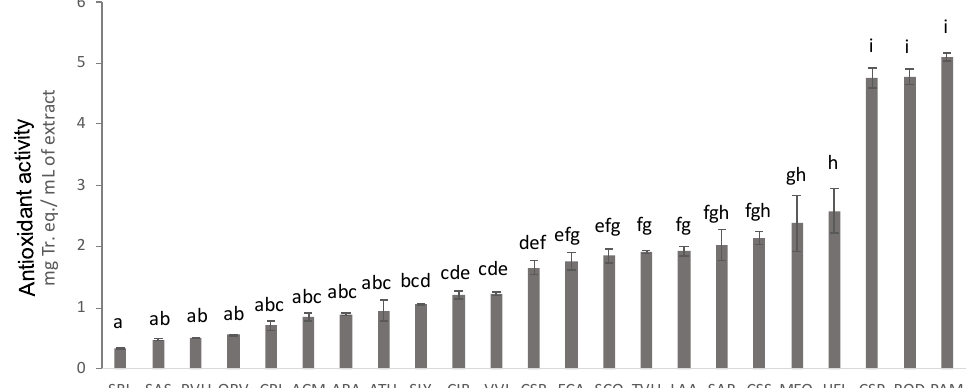
Figure 1. Antioxidant activity expressed in mg of Trolox equivalent/mL of extract, measured by DPPH assay. The samples are indicated on the ‘x’ axis. Different letters within the same assay indicate significant differences in ANOVA tests ( p < 0.05). Results are expressed as means ± SD of three independent experiments. Samples not reported in this figure showed no detectable activity.